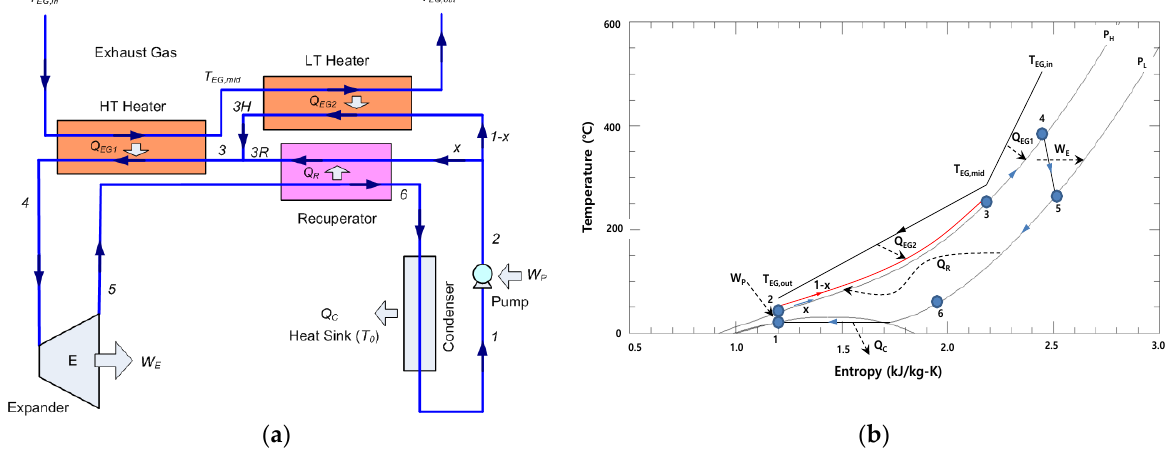
Figure 1. Split S-CO 2 power cycle for WHR from exhaust gas: ( a ) Schematic; ( b ) T-s diagram [10].